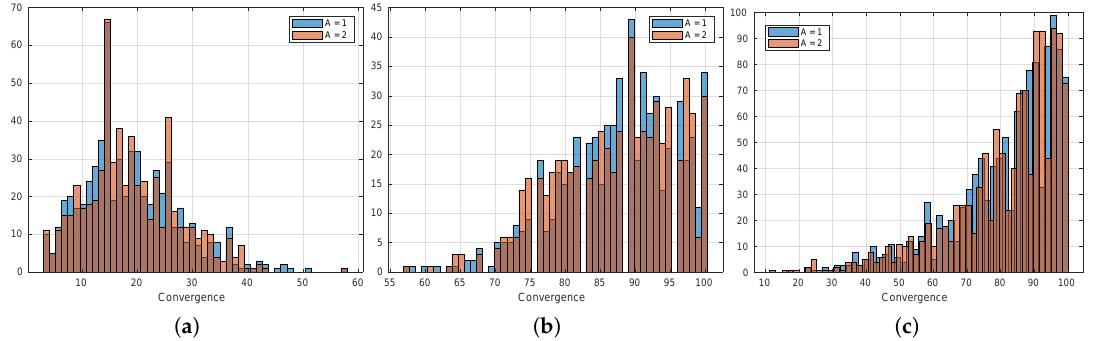
Figure A26. Histograms for the conclusions about the effect of factor A on the convergence performance, represented for the two levels of such factor with additional restrictions on the population. ( a ) Factor B = 1 and factor C = 1. ( b ) Factor B = 1 and factor C = 2. ( c ) Factor B =